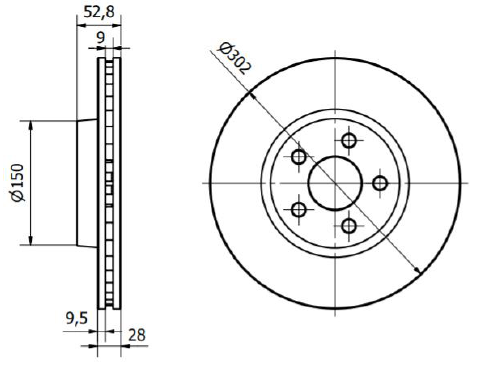
Fig. 2. Basic dimensions of the analyzed brake disc